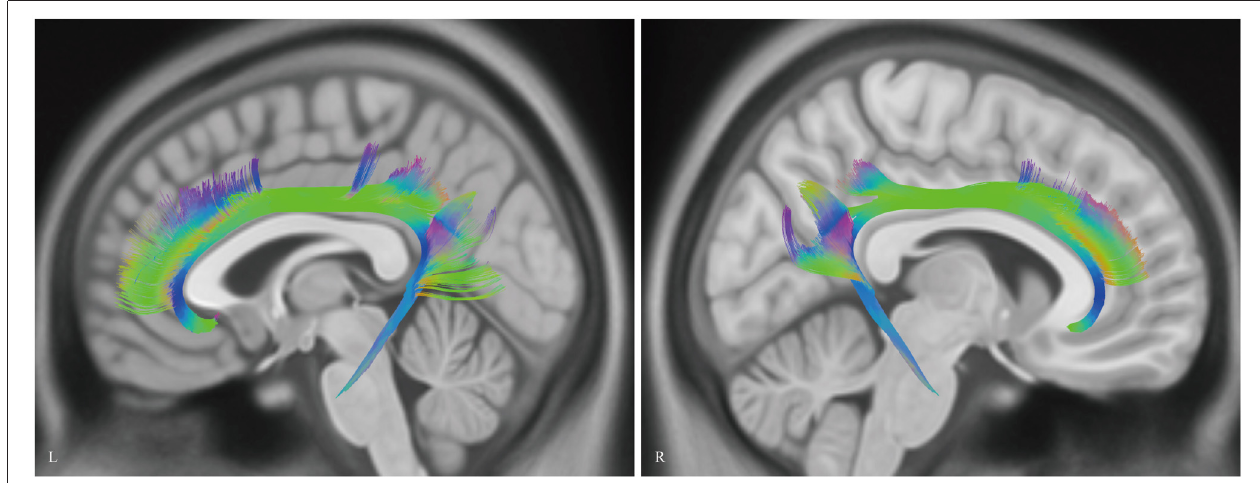
FIGURE 9 | In vivo fiber tractography of the CB on Human Connectome Project (HCP-488) template. CB, cingulum bundle; L, left; R,